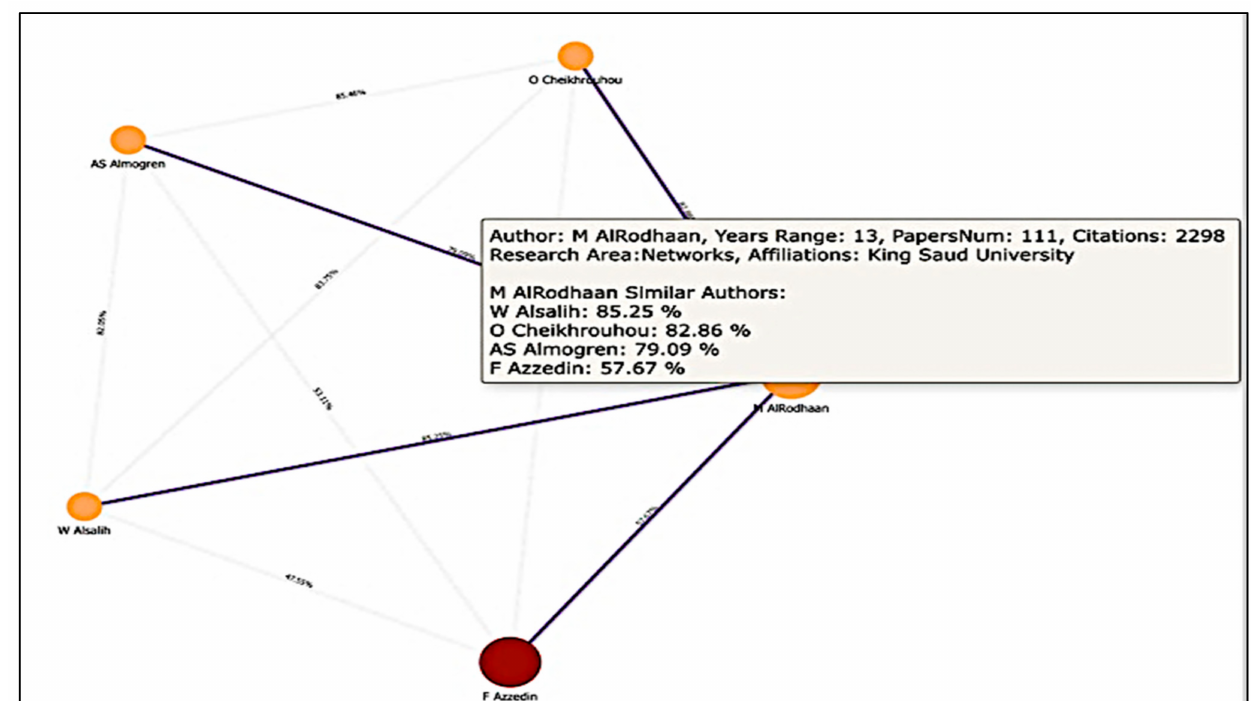
Figure 20. Interactive network’s functionality.